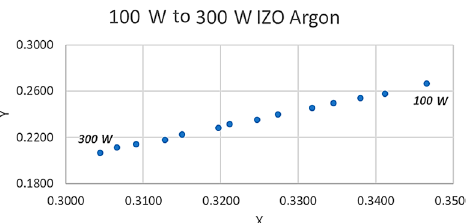
Figure 6. The relationship between the power of plasma (radio frequency (RF)) and the x and y values. The plasma power was raised from 100 to 300 W at a rate of 100 W per minutes and the x and y values were obtained every ~9 s. It can be seen that the x and y values are reduced and the plot demonstrates a linear trend when the sputtering power is increased. These plots indicate that the colour of the plasma is shifting toward deep blue with increasing the power.